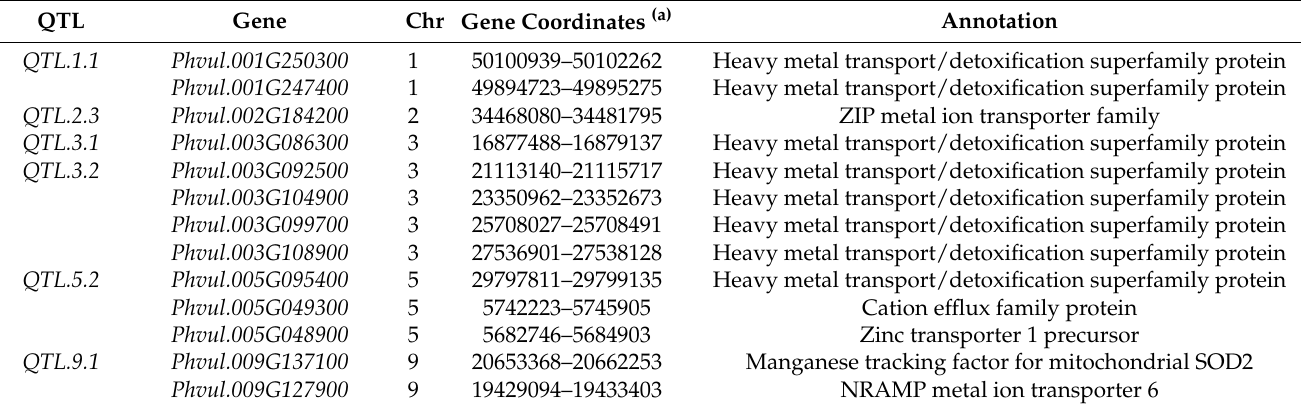
Table 5. Candidate genes co-located in the regions of the quantitative trait loci (QTL). QTL Gene Chr Gene Coordinates (a)